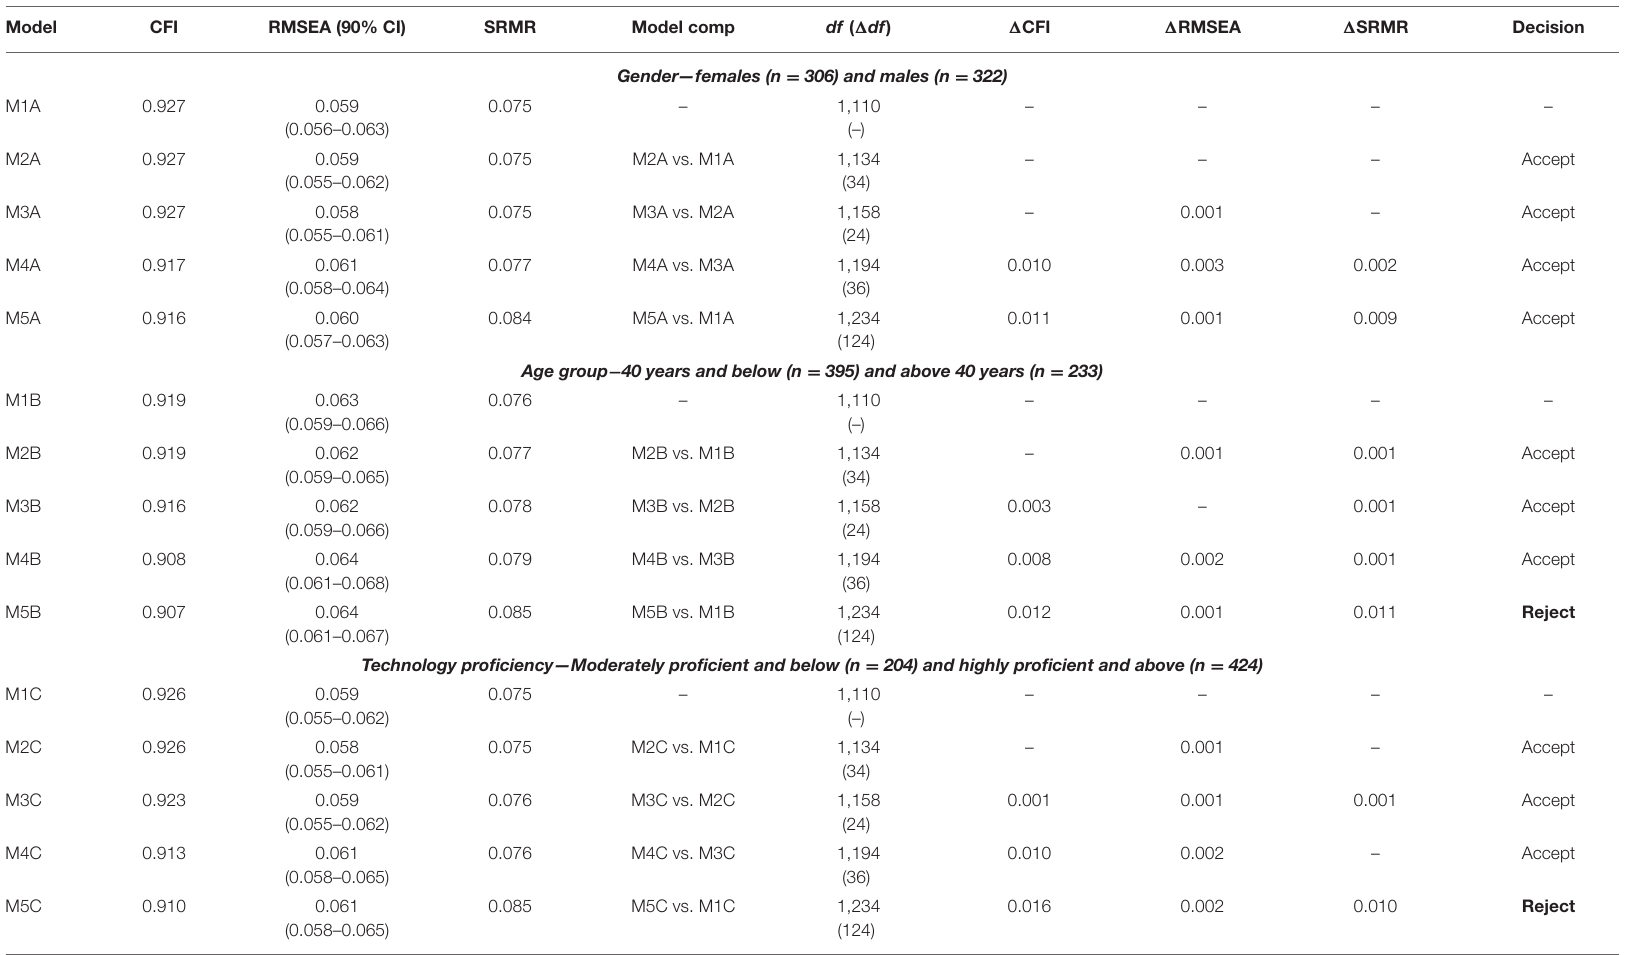
TABLE 3 | Results of measurement invariance analysis.